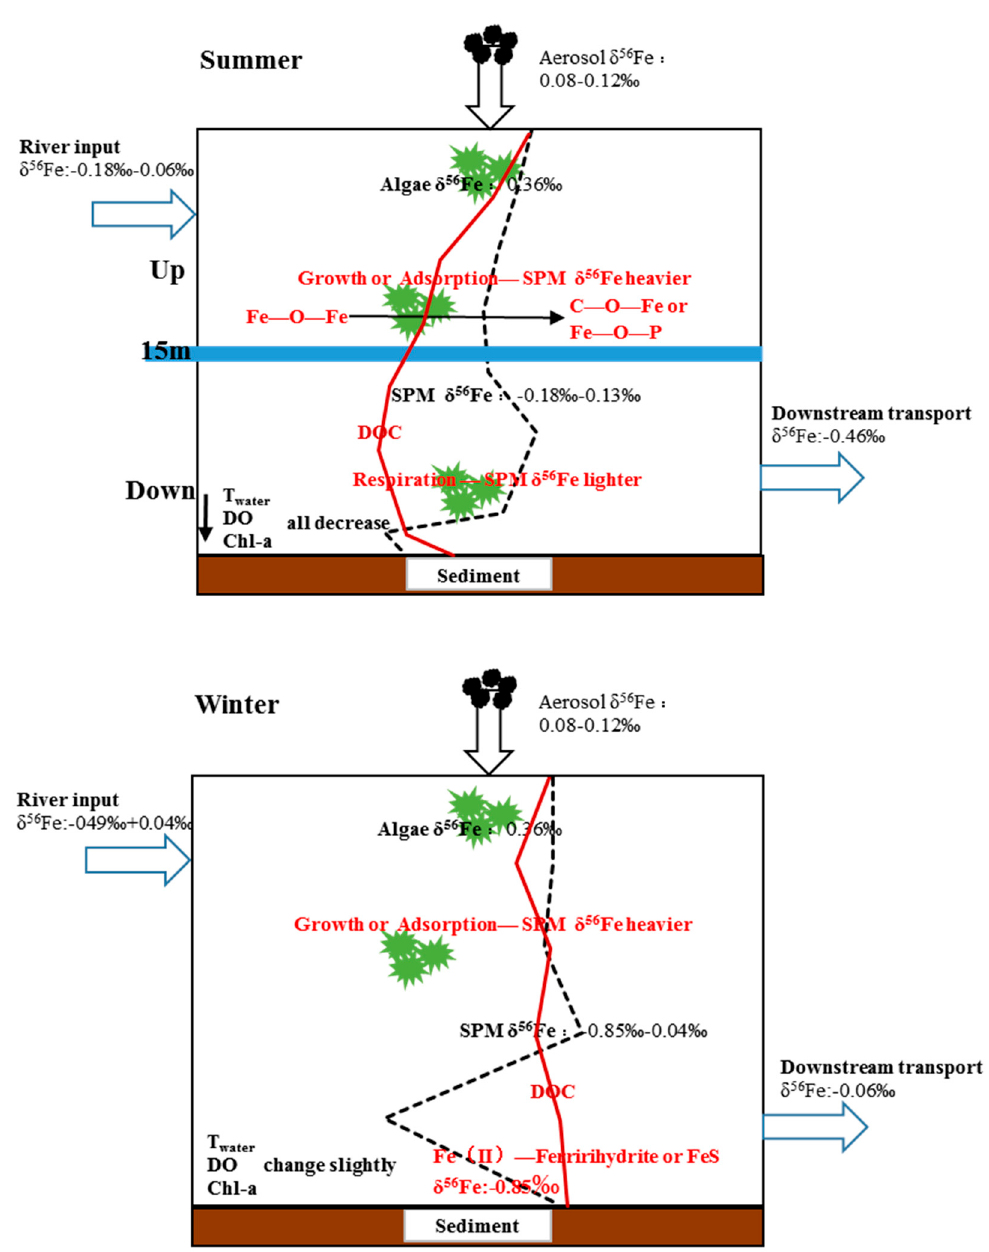
Figure 5. Source analysis of the iron isotope composition of SPM in Hongfeng Lake.